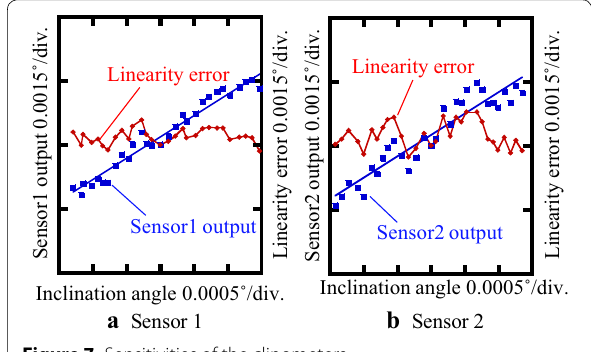
a Sensor 1 Figure 7 Sensitivities of the